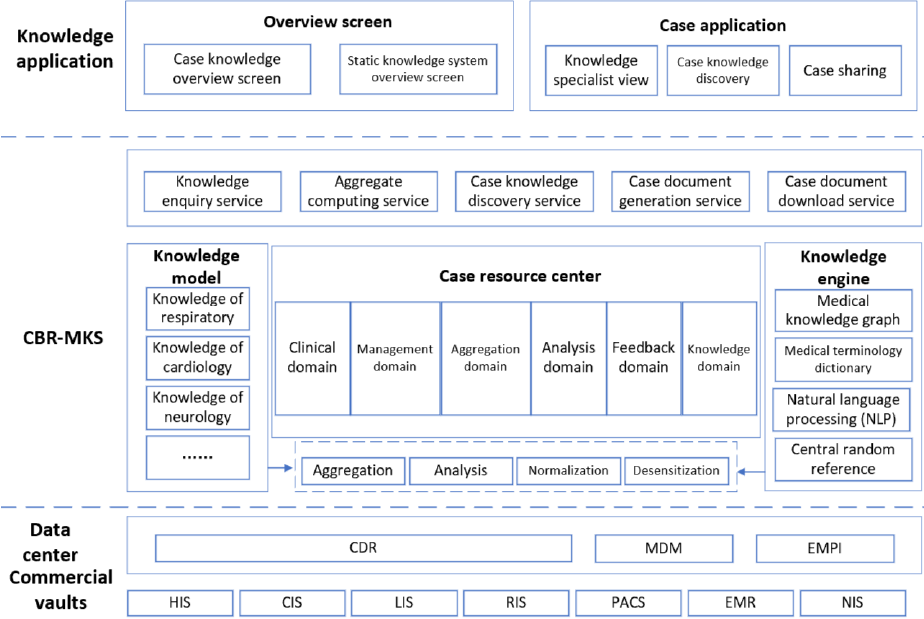
Figure 5. Overall framework of the CBR-MKS.